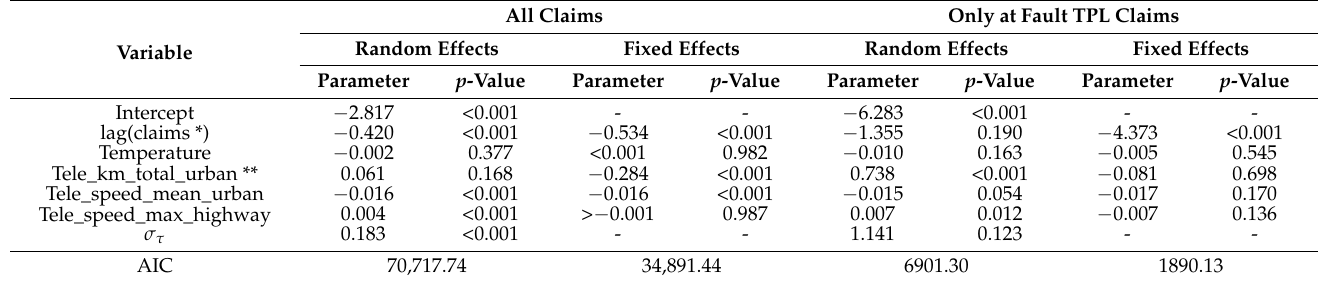
Table A9. Cross-table with the parameter estimates of random effects and fixed-effects Poisson panel data models, with p -values, for the total number of claims (left) and at-fault third party liability (TPL) claims (right) per month and per insured based on the eight observed months in 2018 and 2019, i.e., month 5 is included. The models consider the average monthly temperature as explanatory variable describing weather conditions.